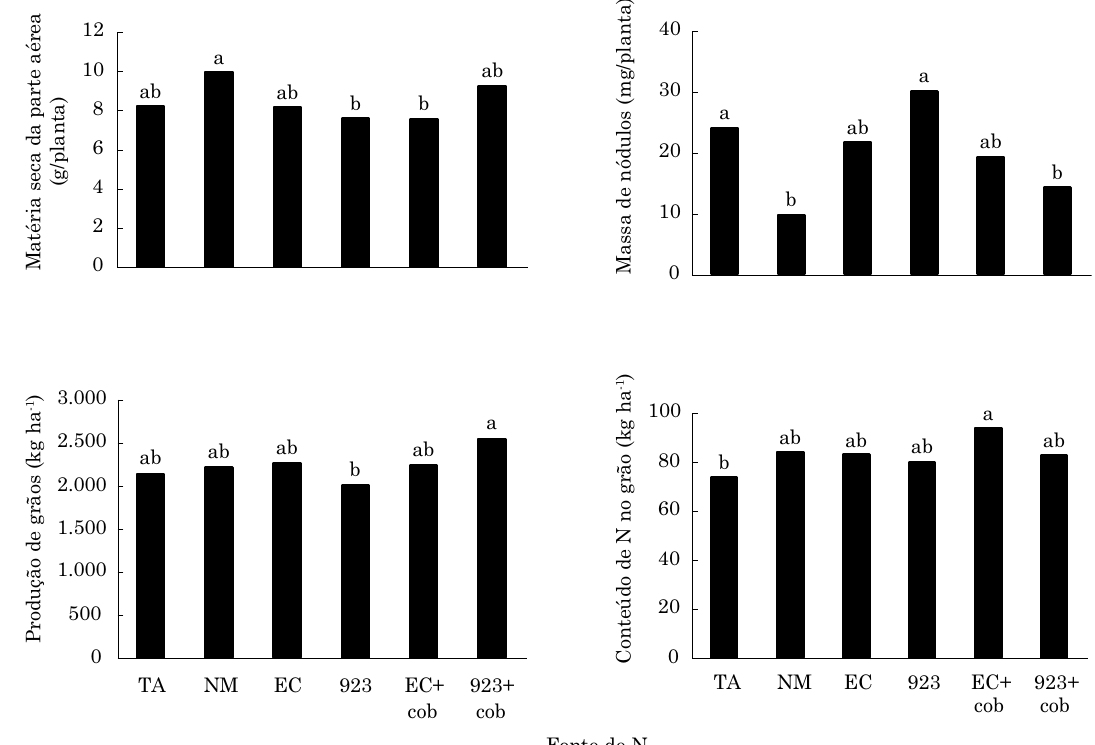
Figura 2. Produção de matéria seca da parte aérea e matéria seca de nódulos quando da floração, da produção de grãos e do conteúdo de N acumulado nos grãos na maturação, da cultivar de feijoeiro comum Ouro Negro, no experimento Goiás II, sem adubação nirogenada (TA - testemunha absoluta) e cinco fontes de N: NM - testemunha nitrogenada (80 kg ha -1 de N no plantio e 40 kg ha -1 de n em cobertura), EC - inoculação com estirpes comerciais de rizóbio (BR 322 + BR 520 + BR 534), 923 - inoculação com a estirpe BR 923 de rizóbio, EC+cob - inoculação com estirpes comerciais e 40 kg ha -1 de n em cobertura e 923+cob - inoculação com a estirpe BR 923 e 40 kg ha -1 de n em cobertura. Barras sobrepostas pela mesma letra indicam que médias não diferem pelo teste de Duncan a 5 %. Coeficientes de variação experimental: produção de parte aérea - 16,3 %; massa de nódulos - 52,9 %; e produção de grãos - 16,6